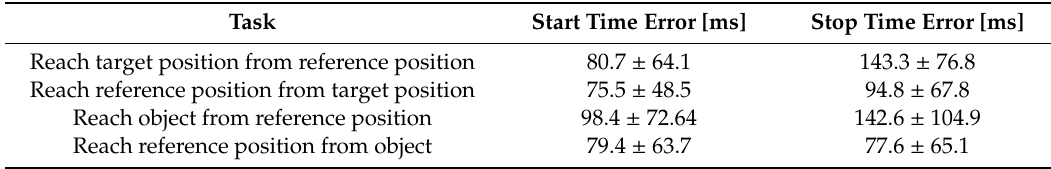
Table 5. Mean ± SD of the error between the start and stop time identified using the force sensors, and the start and stop time computed using RSSI and phase